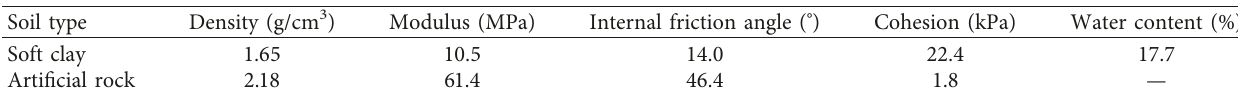
Figure 7: Soil mechanics tests for the model soil. (a) Direct shear test for the soft clay. (b) Shearing test for the artificial Table 3: Mechanical parameters of the model soil.